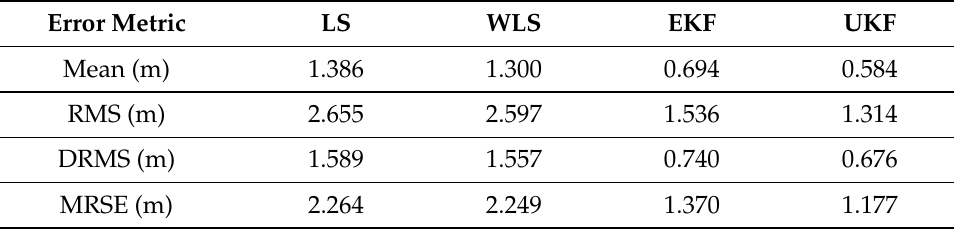
Table 3. Error metrics for 24 h position survey of the reference station antenna using the finalized position